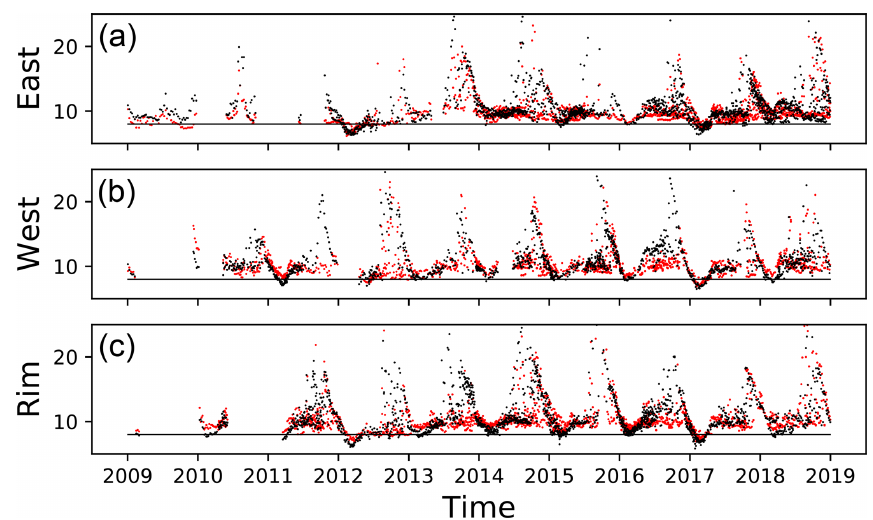
Figure 8. Time series of model and Argo temperature ( ◦ C) at 25m sampled over the three regions shown in Fig. 1: (a) east, (b) west and (c) rim. Black dots indicate data from Argo floats; red dots indicate data from model results.